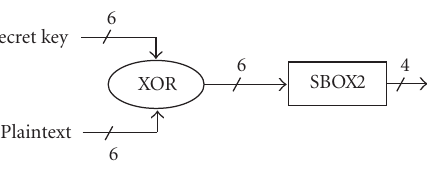
Figure 8: Sensitive submodule of the DES.